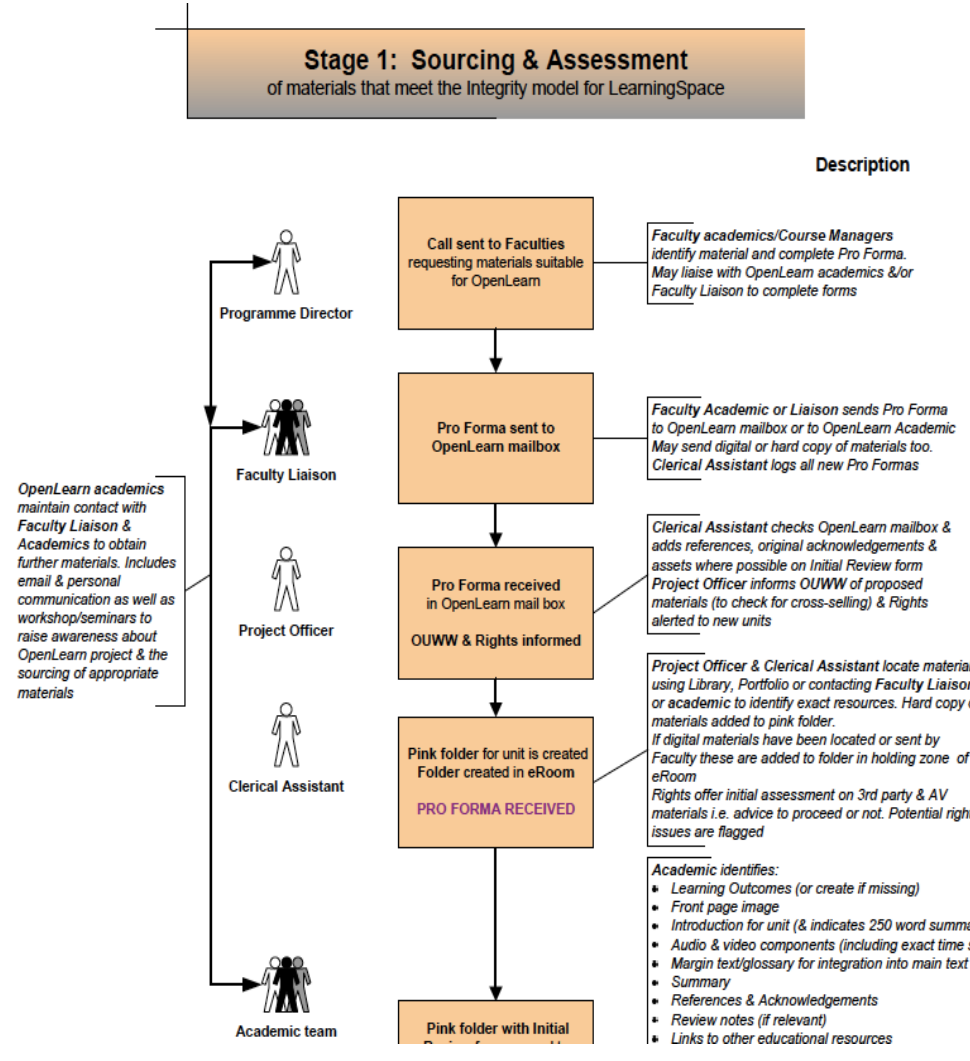
Figure 4 . Snapshot of Stage 1 production flowchart (of 3 stages in